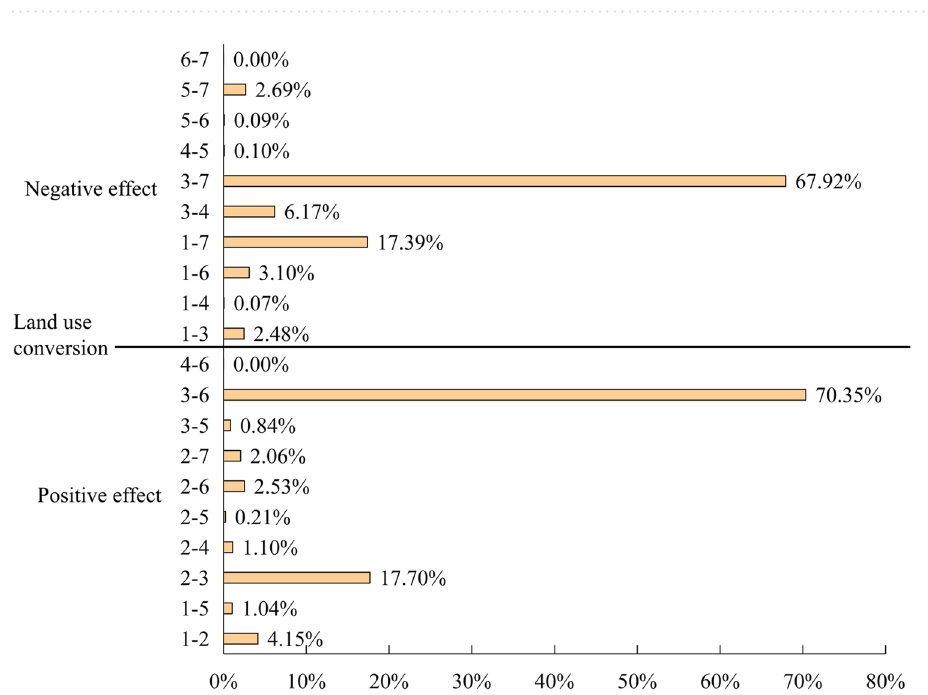
Figure 7. Effects of land use change on carbon sequestration in ecosystems (1: Agricultural production land. 2: Forestry ecological land. 3: Grassland ecological land. 4: Water ecological land. 5: Artificial surface. 6: Desert. 7: Other ecological land). Software: Excel 2021. URL: https:// www. micro soft. com/ zh-